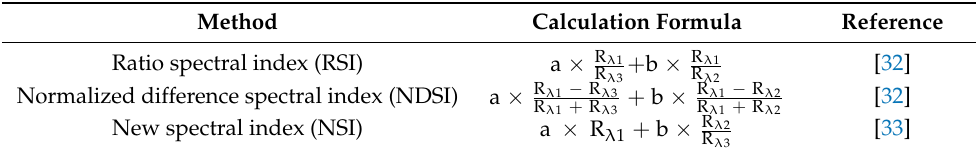
Table 3. Commonly used SI construction methods.